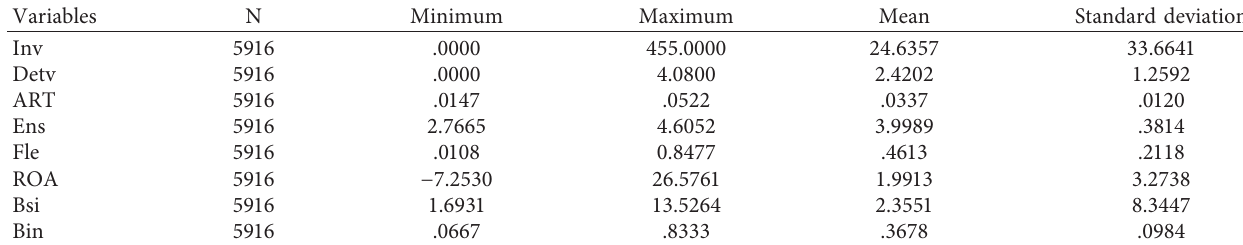
Table 2: Descriptive statistical results of main variables.